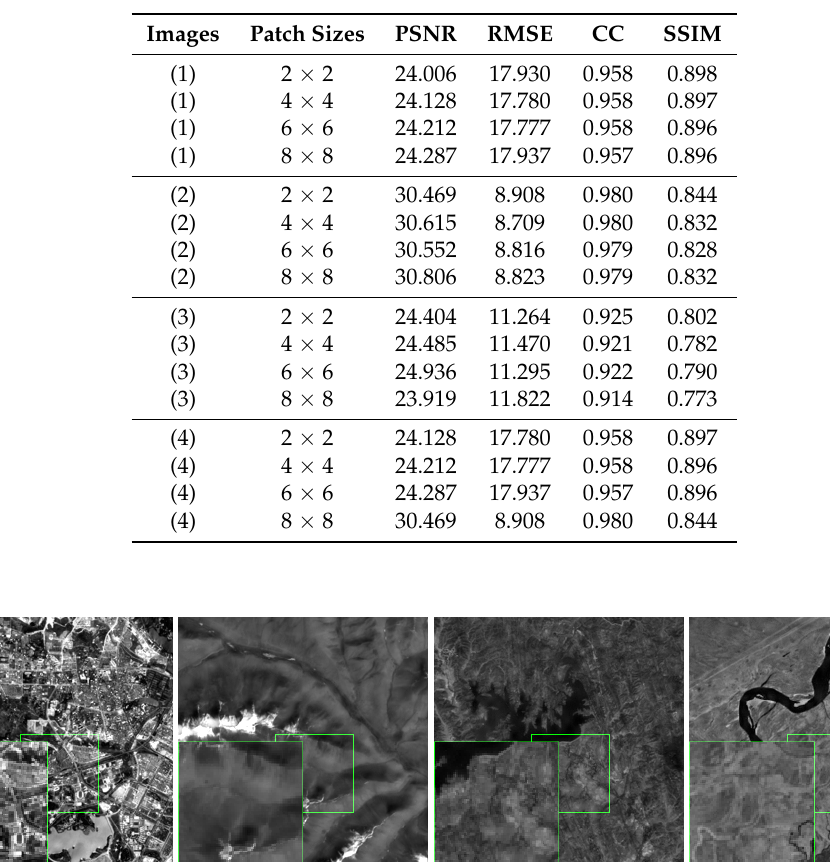
Table 3. The performance indexes PSNR (dB), RMSE, correlation coefficient (CC) and structural similarity (SSIM) of the Log function with different images and patch sizes.